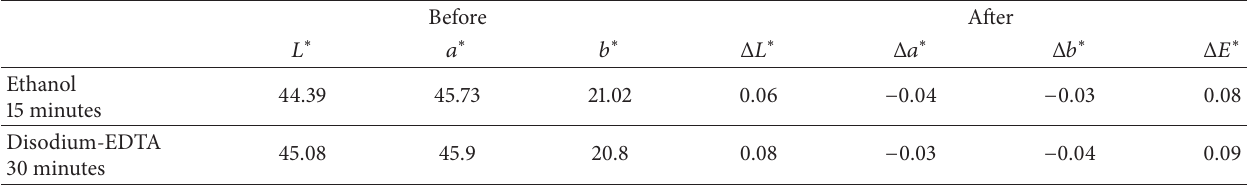
Figure 6: Upper trace: Raman spectrum from the blue thread of an XVIth century tapestry (Italian artwork) shown in (b). Lower trace: SERS spectrum (514nm excitation) of indigo extracted from the same sample by using an agar gel bead containing the leuco -reduction chemicals. Adapted from [37]. Table 1: Change in color (CIE 𝐿 ∗ 𝑎 ∗ 𝑏 ∗ system) of the cotton mockup dyed with alizarin upon extraction with the Ag-agar gel added with either ethanol or disodium-EDTA solution.